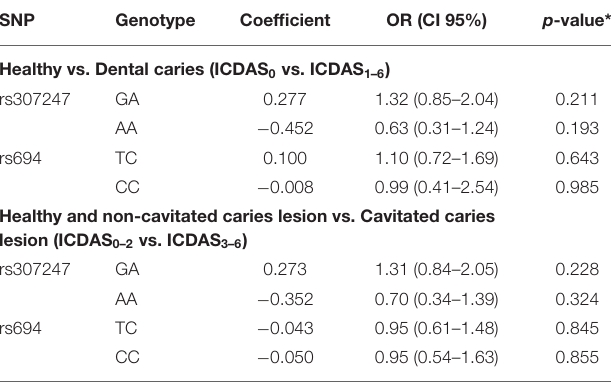
TABLE 5 | Multiple Logistic Regression adjusted by